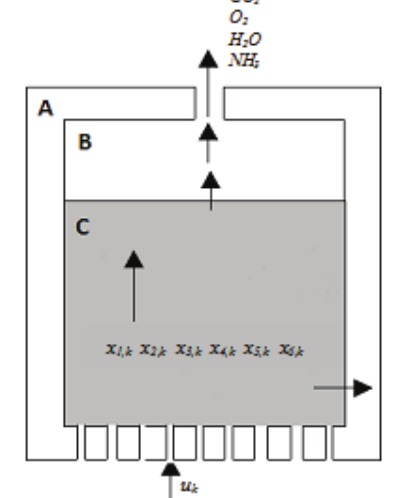
Fig. 1 – Experimental reactor scheme. A: Wall, B: Head- space, C: Substrate, Fig. 1 Experimental reactor scheme. A: Wall, B: Headspace, C: Substrate, x = Dynamical states, u = Input air flow i k